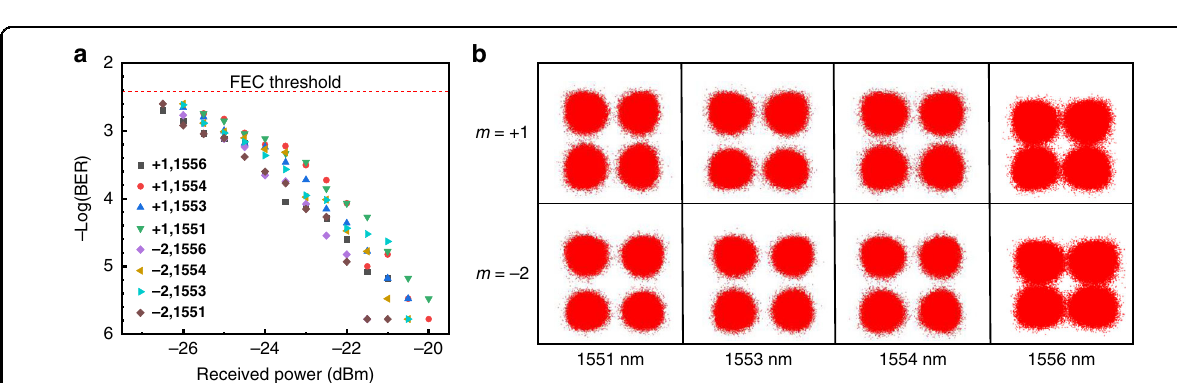
Fig. 6 Demonstration of the CVB mode multiplexer/demultiplexer is compatible with wavelength multiplexing. a Measured BERs of two CVB modes at four wavelengths. b Constellations of QPSK signals carried by CVB modes ( m = − 2, m = + 1) at different wavelengths (1551, 1553, 1554, and 1556